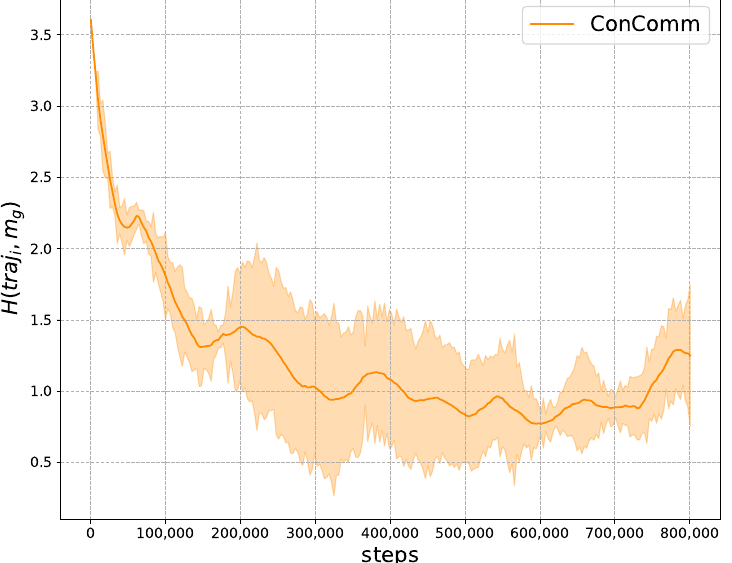
Figure 8. The cross entropy between the vehicles aggregated message m g and moving policy µ i represented as traj i . The value is lower when the message is more correlated with the vehicles’ moving